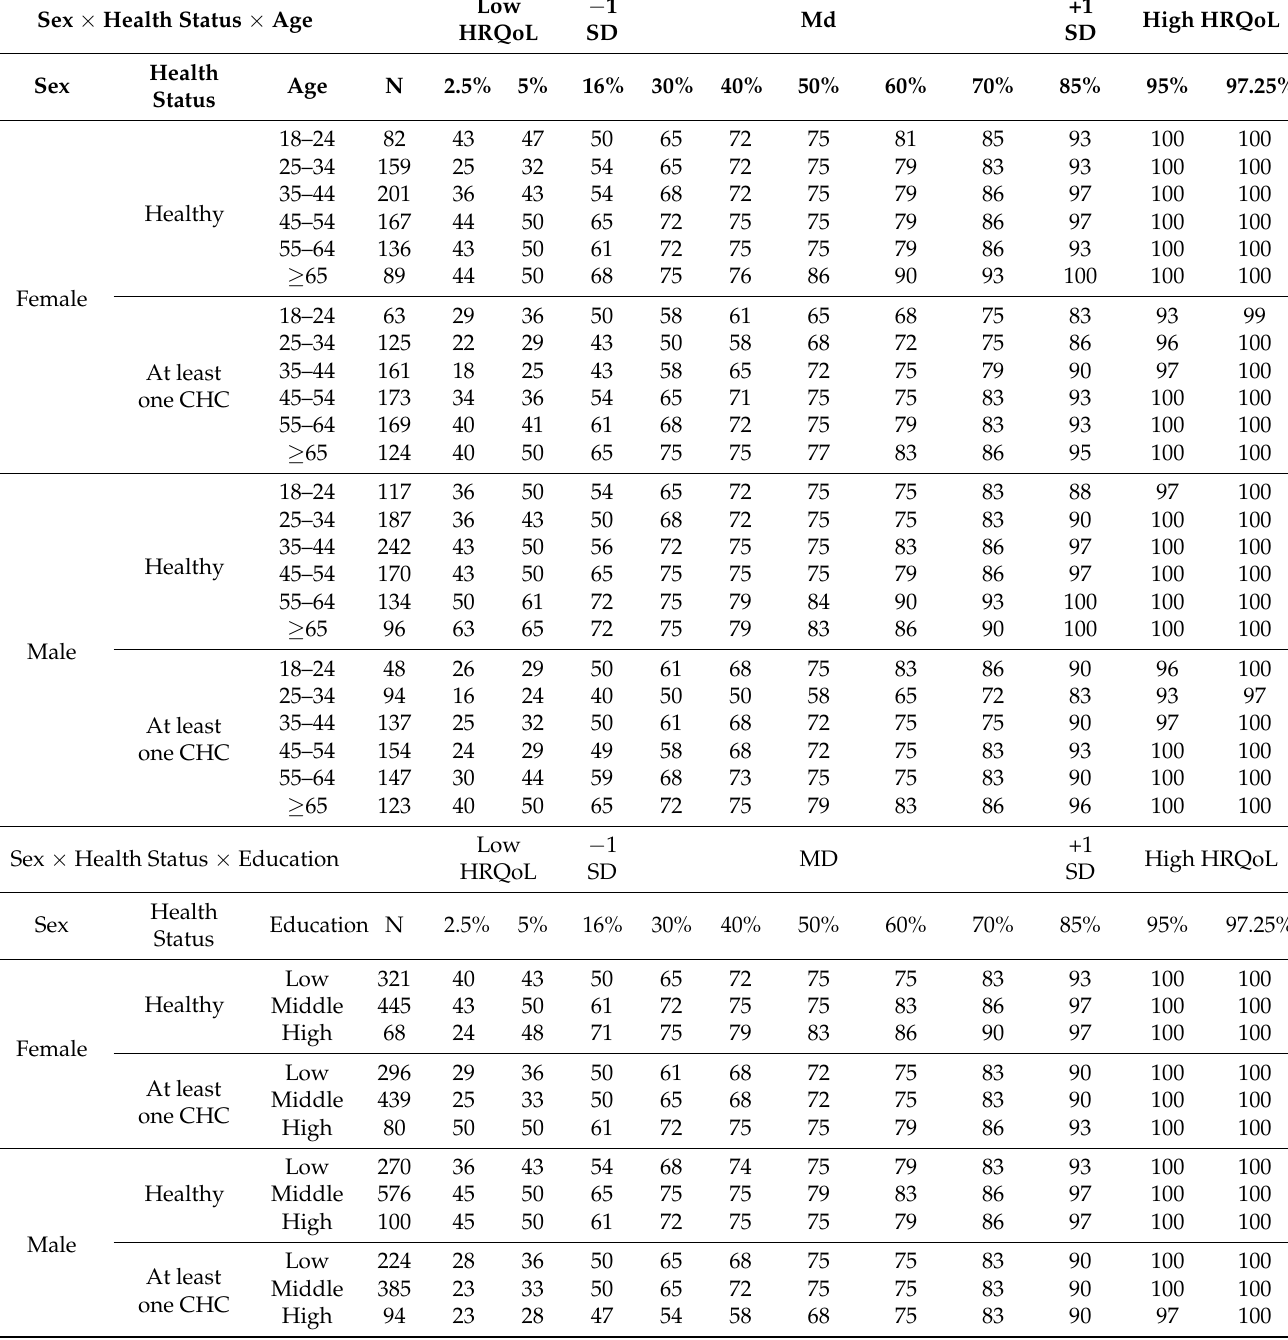
Table A4. Reference values for the QOLIBRI Cognition scale obtained from the general population sample in Italy stratified by sex, health status, age, and